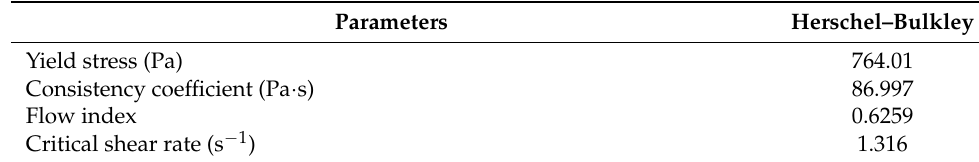
Figure 3. Fluid simulation model: ( a ) flow field and free flow field; ( b ) meshing; ( c ) boundary conditions.